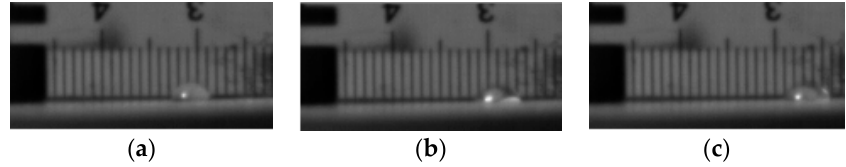
Figure 15. The movement characteristics of droplet under DC positive polar power source. ( a ) droplet without applied voltage ( b ) droplet begin to add voltage ( c ) droplet with voltage of 10 kV.